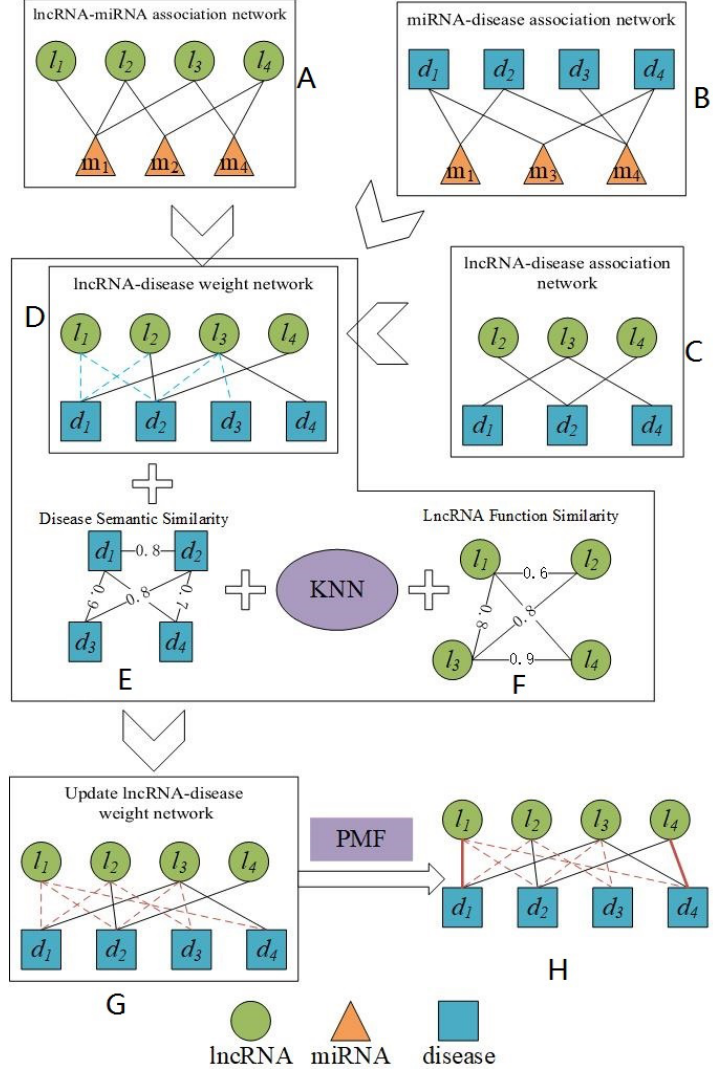
Figure 1. The flowchart of our prediction model of